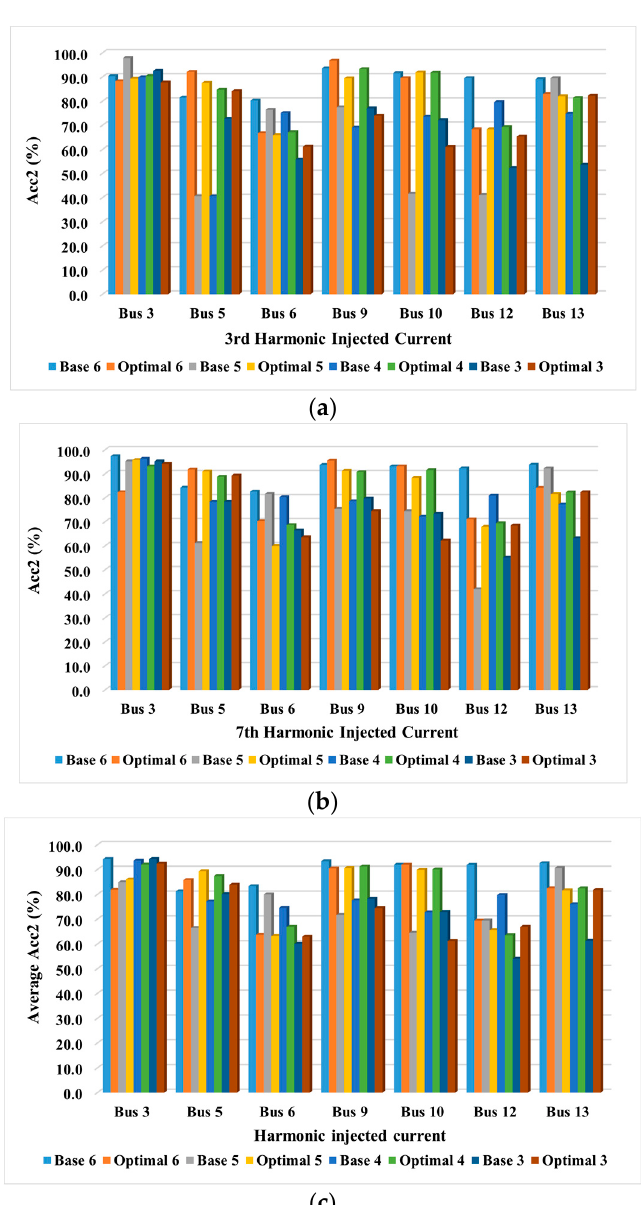
Figure 8. Accuracy of harmonic current level classifiers for different metering scenarios: ( a ) 3rd harmonic, ( b ) 7th harmonic, ( c ) average of all harmonic orders.